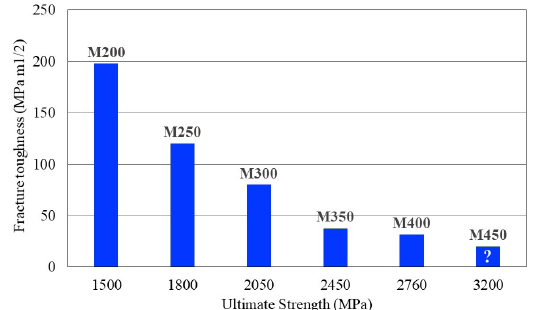
) with the UTS of IC